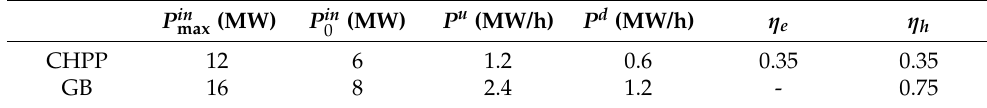
Table 1. Parameters of combined heat and power plant and gas boiler.